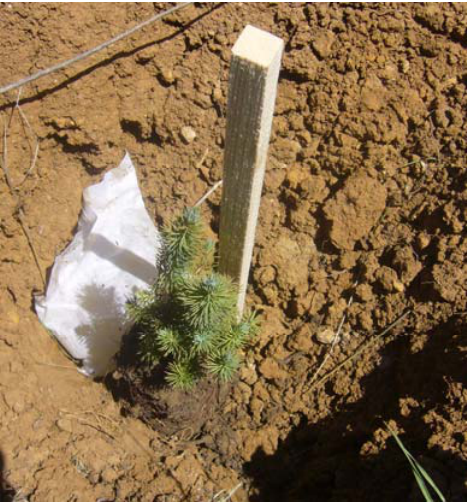
Figure 4. Rechargeable Solid Water (RSW) bag placed near stone pine root zone. Irrigation or rain can recharge bag for slow release.